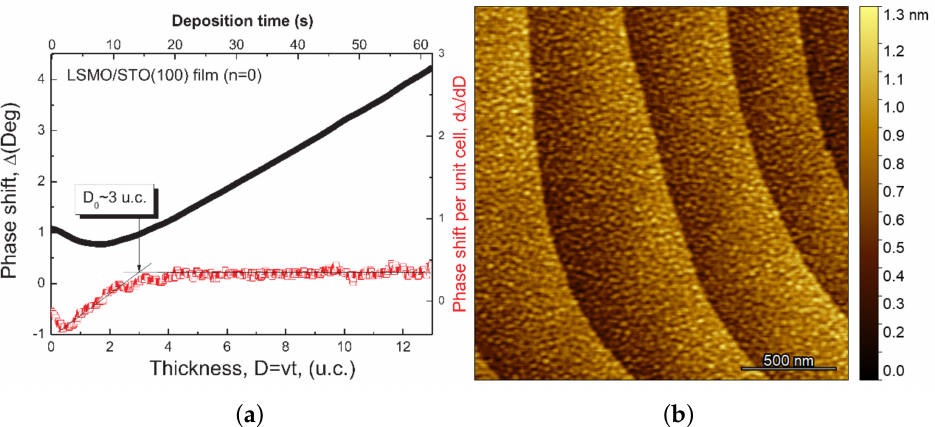
Figure 2. ( a ) The time dependence of the phase shift angle, ∆ ( t ), during the growth of a 5 nm thick La 0.7 Sr 0.3 MnO 3 / SrTiO 3 (LSMO / STO) (100) film. After overcoming a transition region of D 0 ≈ 3 u.c., a linear increase in ∆ with time is evident in agreement with a constant deposition rate, v ≈ 4.8 nm / min. “Reprinted figure from [34] under permission licensed by John Wiley and Sons (Nr. 4654230253827)”; ( b ) paramagnetic-antiferromagnetic (AFM) image of epitaxial LSMO / STO(100) film reveals a layer-by-layer growth with one atomic layer height terraces and mean square roughness, RMS = 0.2